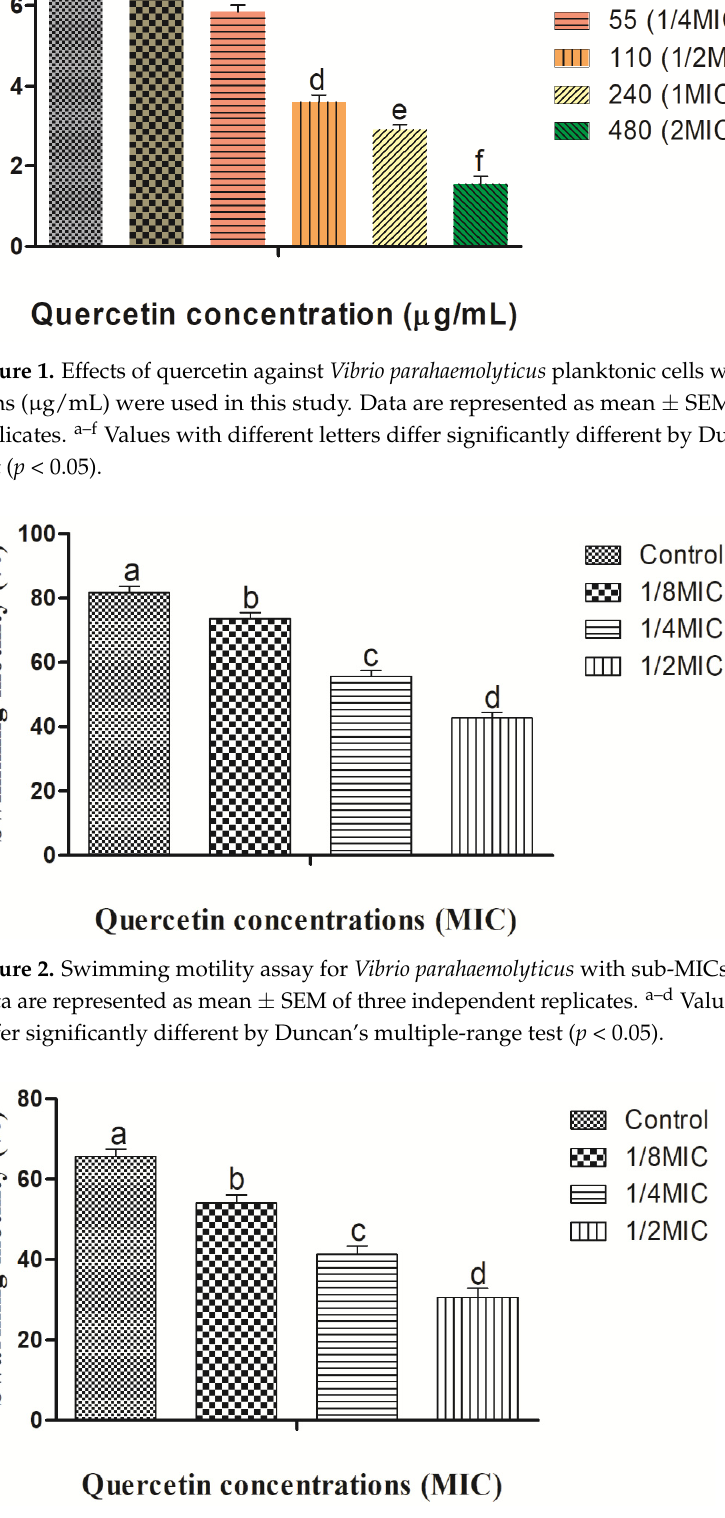
Figure 3. Swarming motility assay for Vibrio parahaemolyticus with sub-MICs of quercetin (µg/mL). Data are represented as mean ± SEM of three independent replicates. a–d Values with different letters differ significantly different by Duncan’s multiple-range test ( p < 0.05).